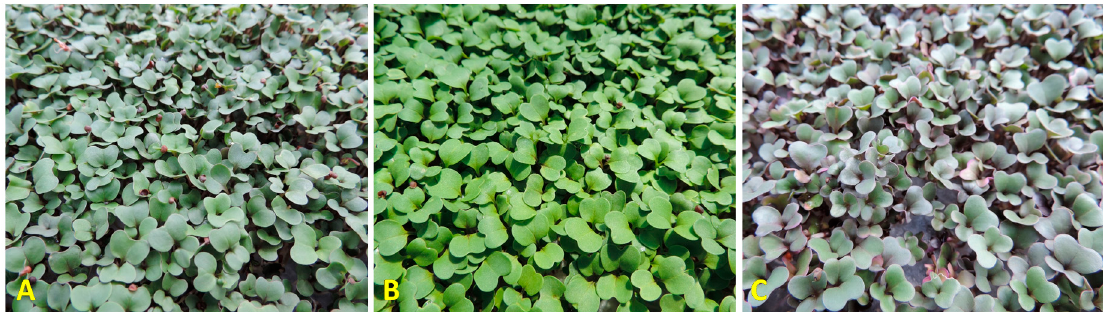
Figure 1. Genotypes used for producing microgreens: ( A ) broccoli, cultivar ‘Broccolo natalino’; ( B ) broccoli raab, local variety ‘Cima di rapa novantina’; ( C ) cauliflower, cultivar ‘Cavolfiore violetto’.